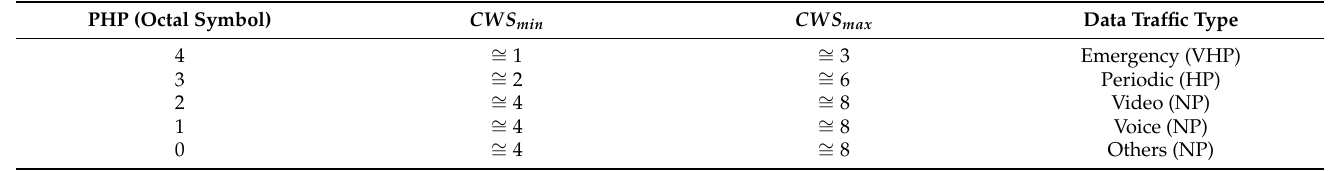
Table 3. IEEE 802.15.6-based CSMA/CA-MAC Protocol Data Traffic